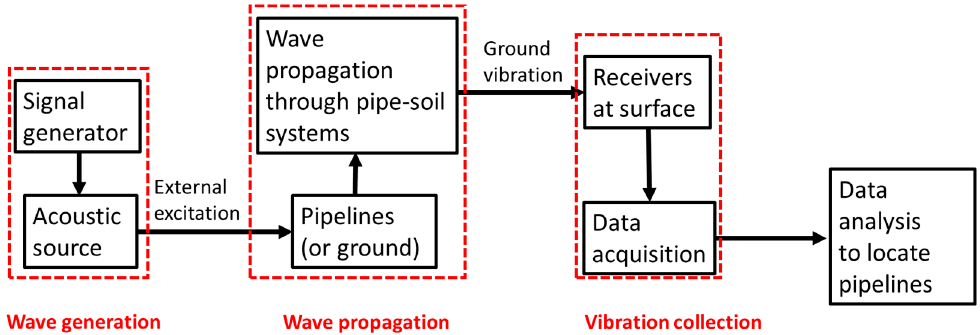
Figure 3. Block diagram showing the principle of acoustic pipe localization methods.